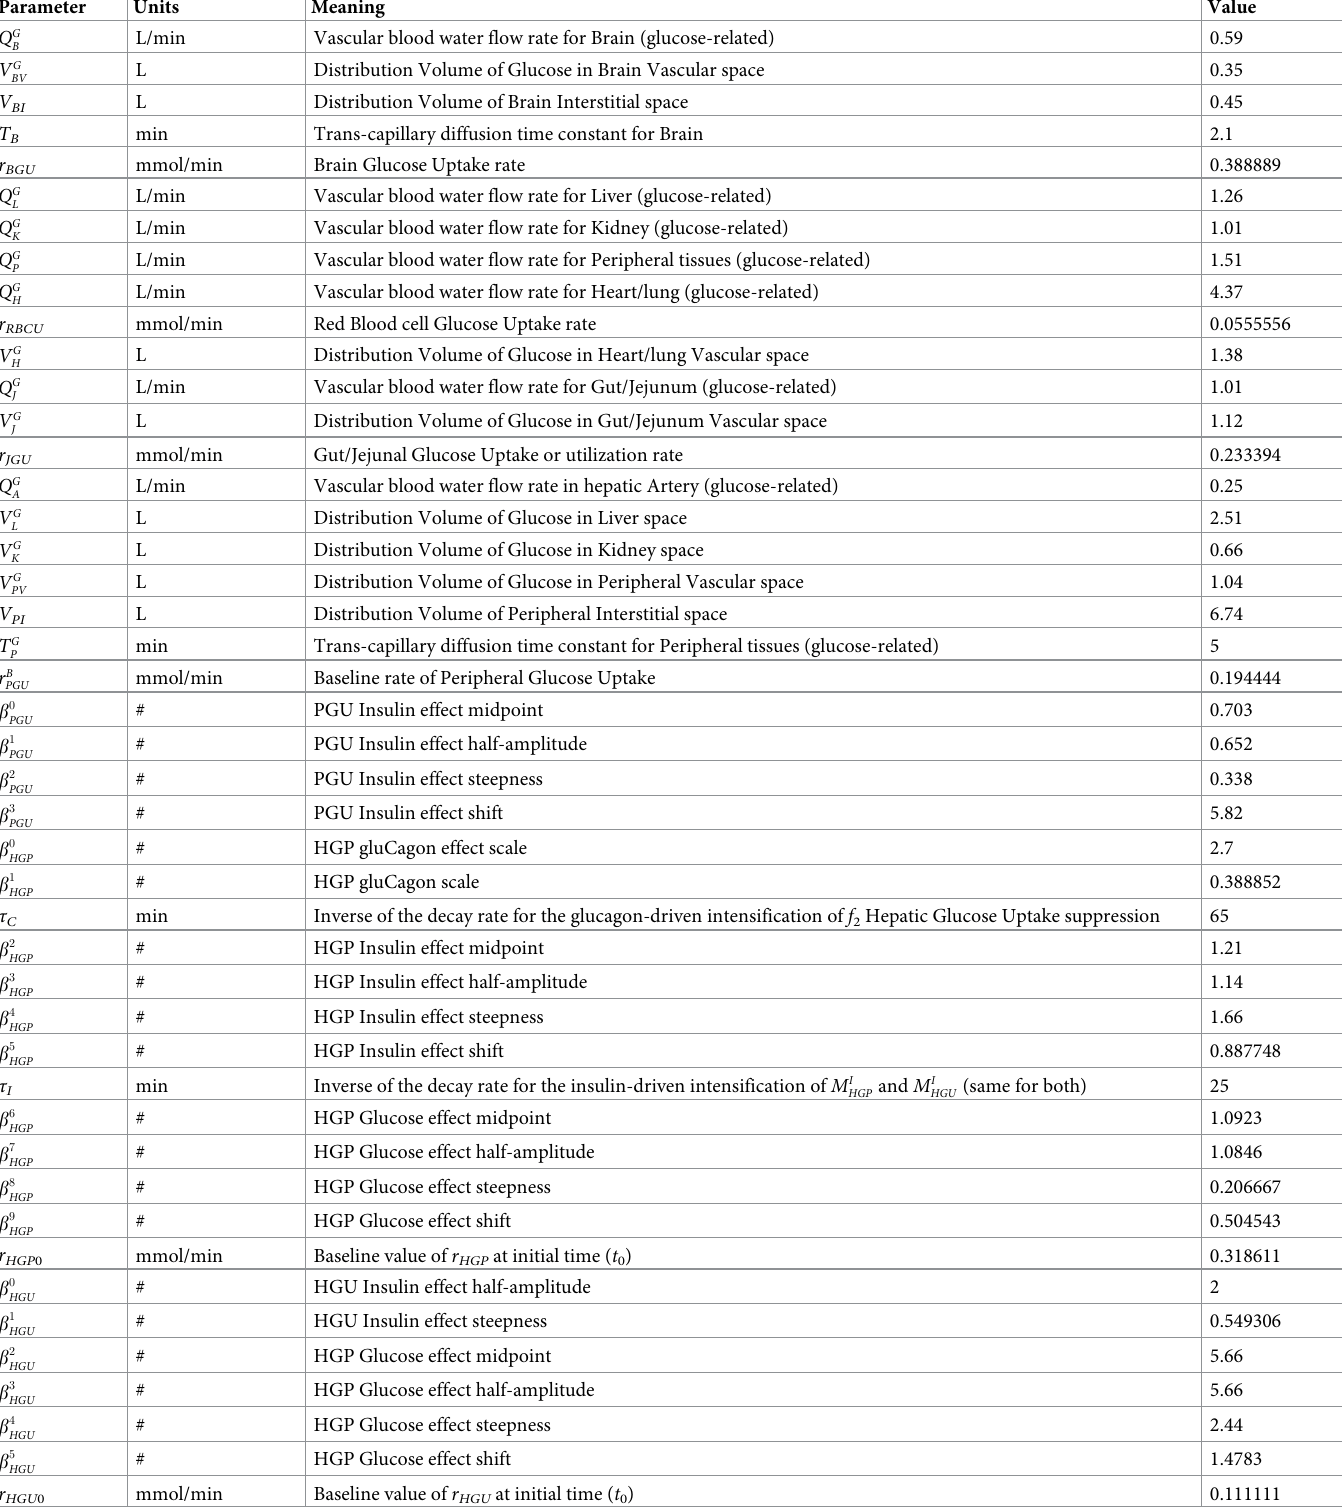
Table 2. Sorensen model